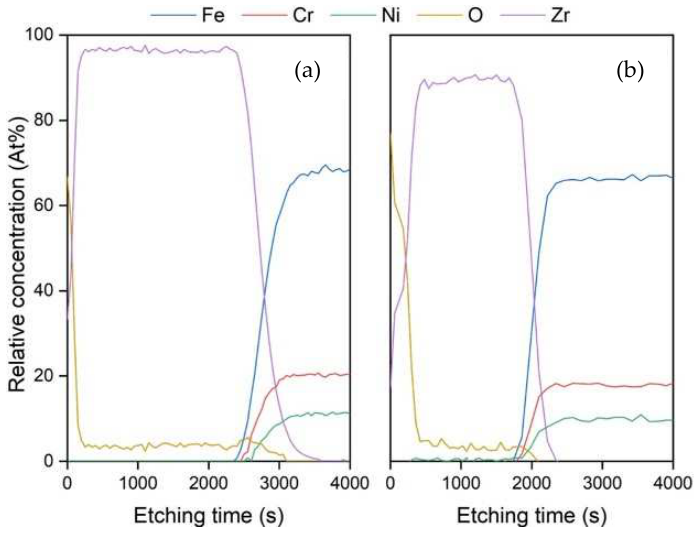
Figure 12. XPS depth profiles of Zr + -etched and Zr-coated sample ( a ) before and ( b ) after 48 h of immersion in nitric acid solution at boiling temperature.